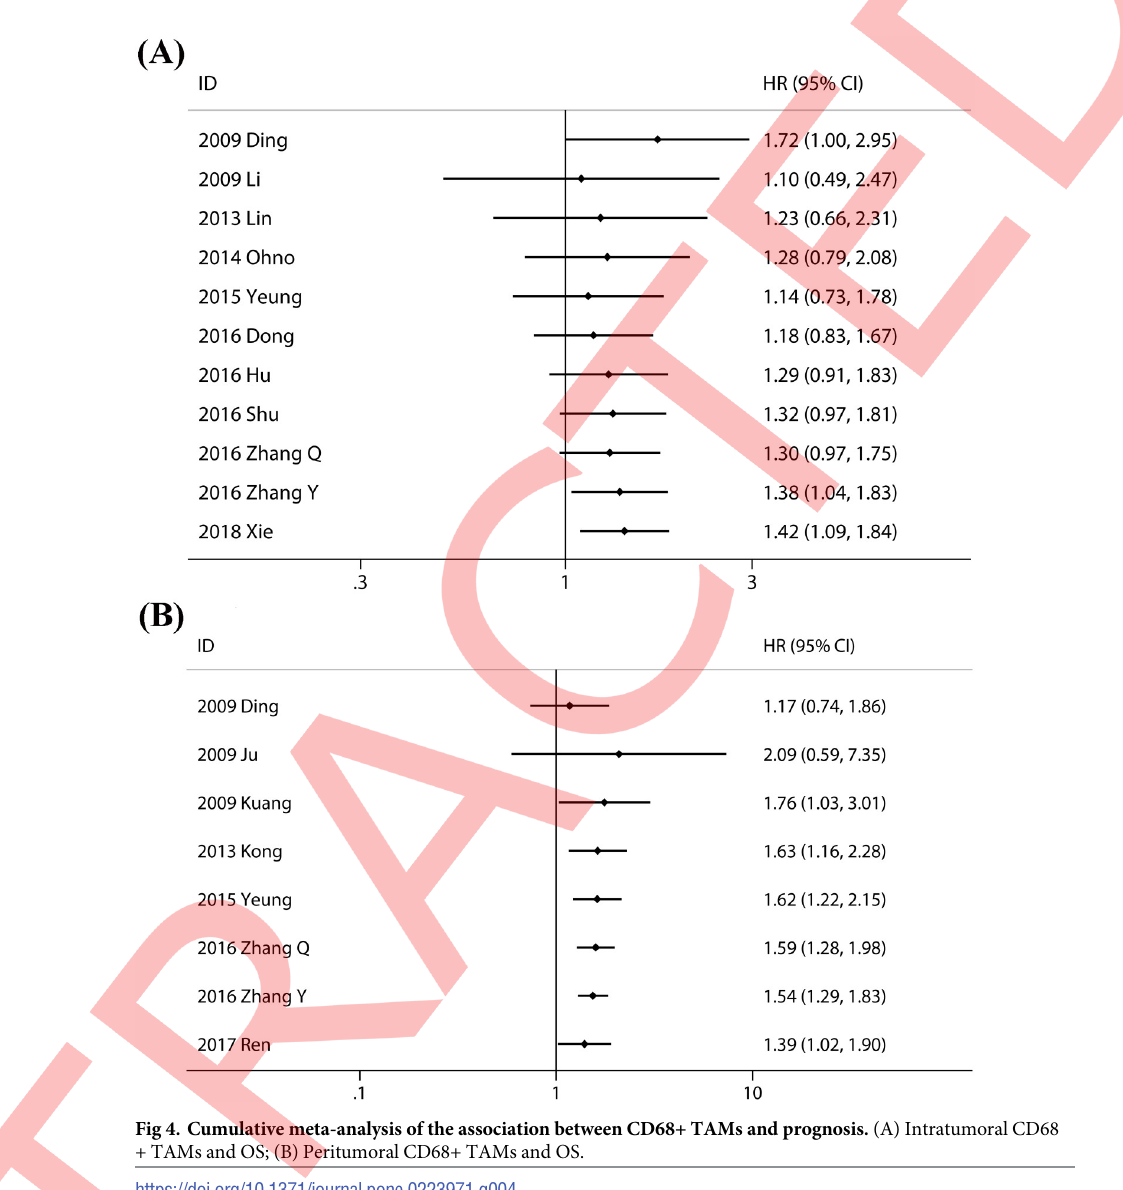
Fig 4. Cumulative meta-analysis of the association between CD68+ TAMs and prognosis. (A) Intratumoral CD68 + TAMs and OS; (B) Peritumoral CD68+ TAMs and OS.